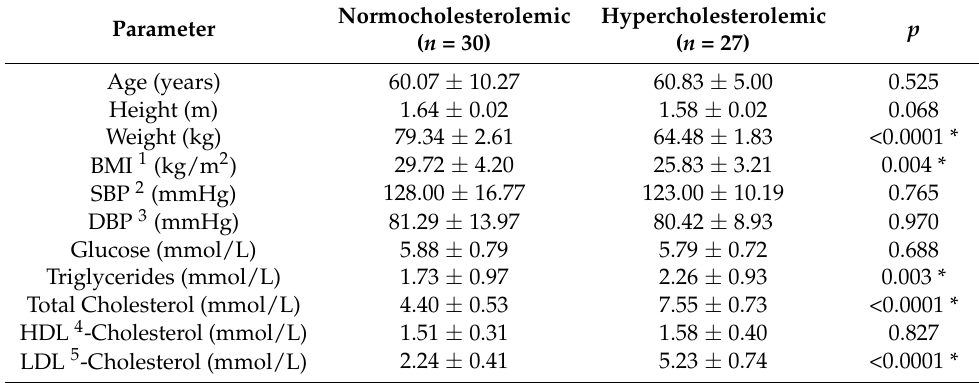
Table 1. Anthropometric and biochemical characteristics of hypercholesterolemic and normocholes- terolemic